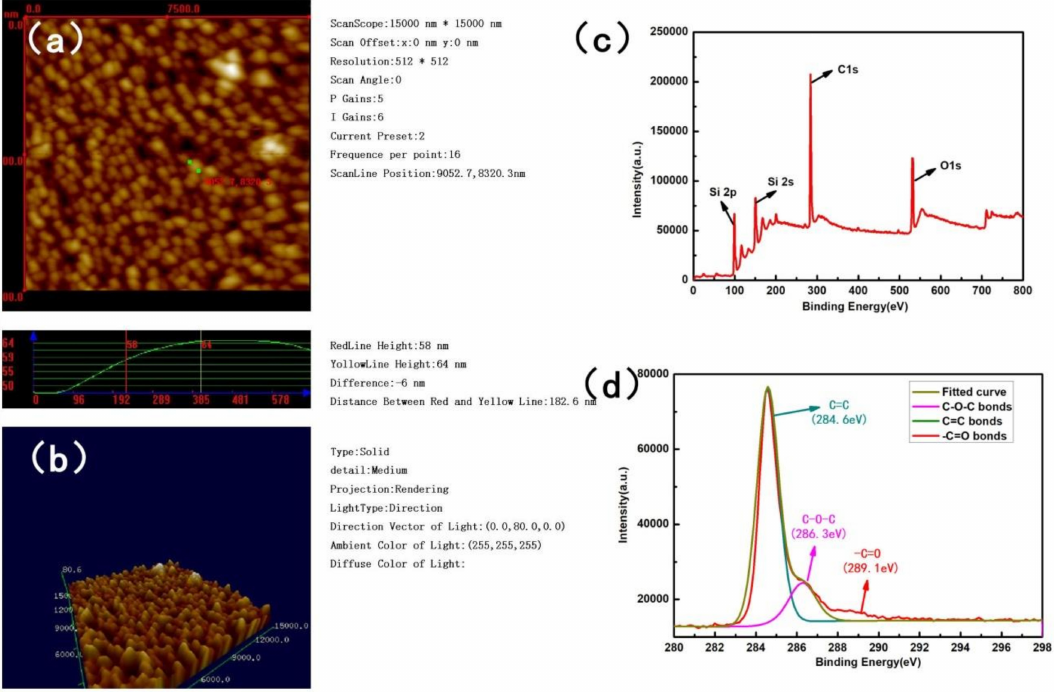
Figure 2. ( a ) 2D AFM images of the films; ( b ) 3D AFM topography of the films; ( c ) XPS wide surface survey of the NGFs; ( d ) narrow scans for